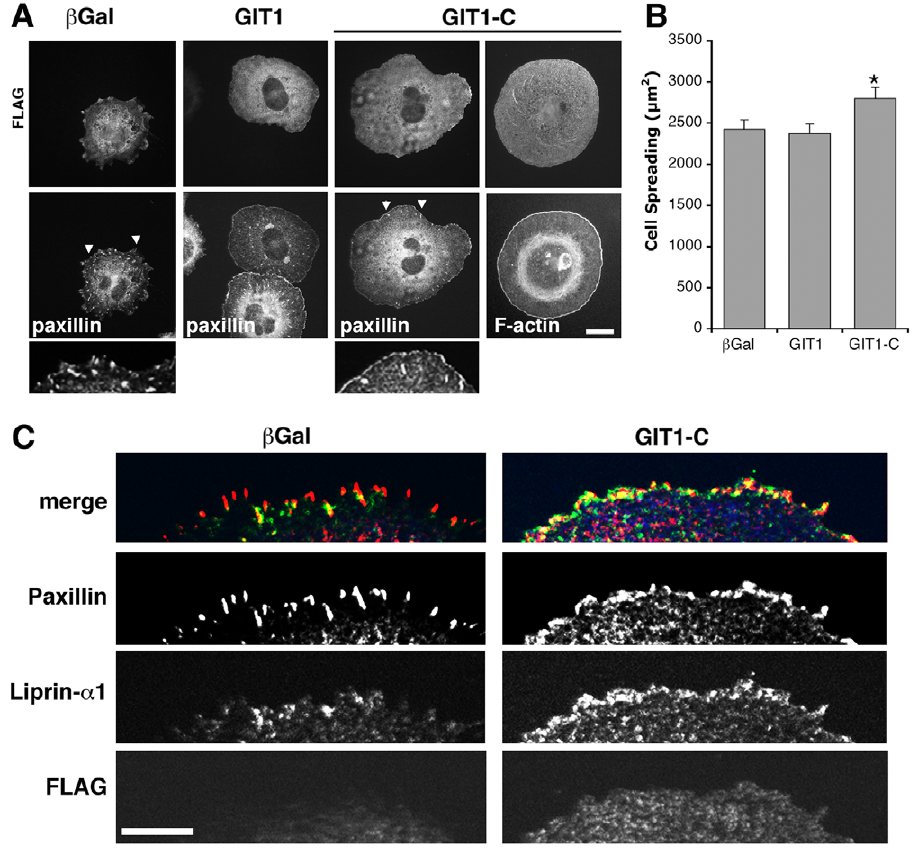
Figure 4. Expression of GIT1-C affects cell morphology and the distribution of endogenous liprin- a 1. (A) COS7 cells transfected for one day with either FLAG-GIT1, FLAG-GIT1-C, or FLAG- b Galactosidase were re-plated for 1 h on FN. Immunofluorescence for the transfected proteins (FLAG), paxillin, and phalloidin staining for F-actin. Scale bar, 20 m m. Below, 3-fold enlargements of areas from cells stained for paxillin (arrowheads in the corresponding cells above) are shown. (B) Expression of GIT1-C induces a significant increase of cell spreading on FN. Bars are means 6 SEM (n=116–121 cells per condition); *P , 0.05. (C) Cells transfected with either FLAG- b Galactosidase or FLAG-GIT1-C were used for triple immunofluorescence staining with antibodies for endogenous liprin- a 1, paxillin, and transfected proteins (FLAG): endogenous liprin- a 1 accumulates at the edge of GIT1-C-transfected cells. Scale bar, 5 m m.